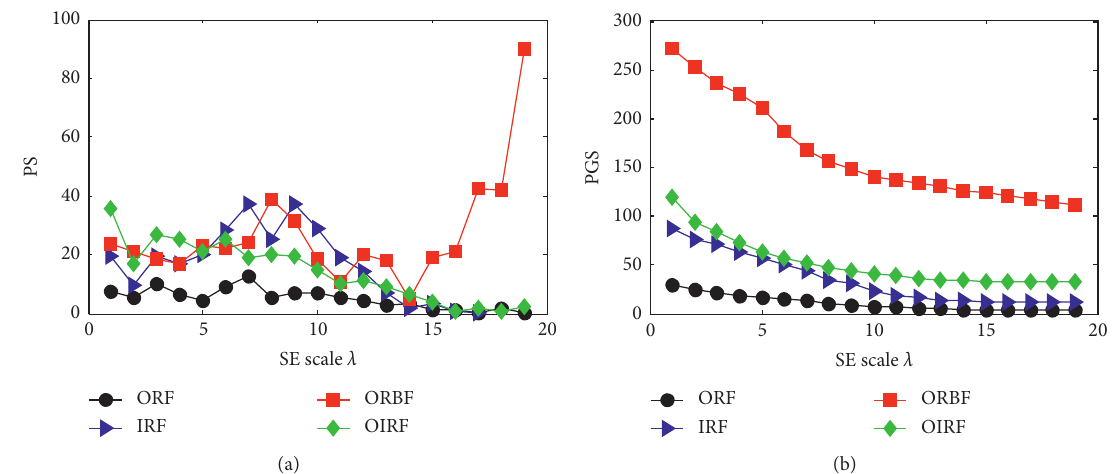
Figure 27: Curves of different bearing fault signals in case 2: (a) PS and (b) PGS.